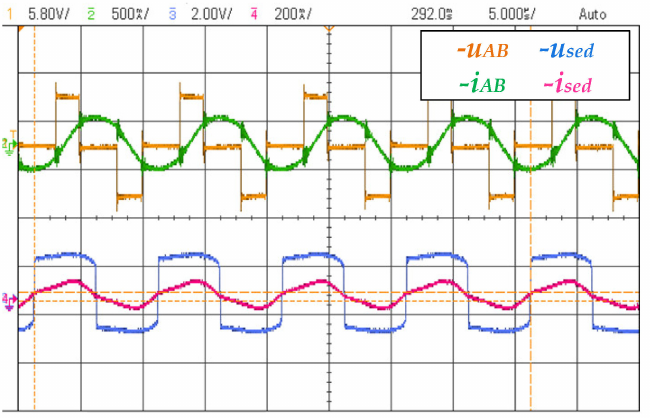
Figure 21. Waveforms of the current and voltage on the primary and secondary sides of the resonator when using auxiliary inductance.